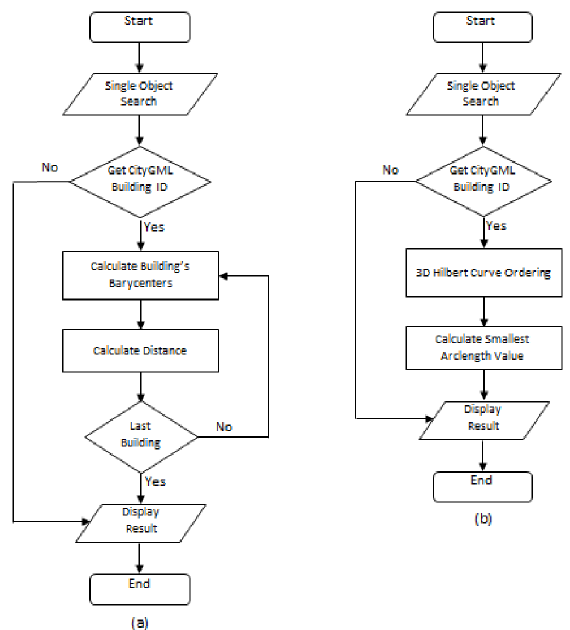
Figure 13: Flowcharts for finding the nearest building for CityGML data (a) and with 3D Hilbert’s curve implementation